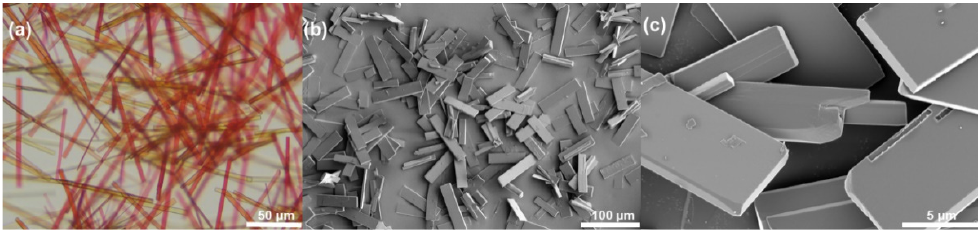
Figure 3. ( a ) Optical microscopy image of APE-TCNB solid cocrystals grown in SDS; ( b ) the SEM image of APE-TCNB solid cocrystals; ( c ) the SEM image of a fractured APE-TCNB solid cocrystal shows the interior structure.